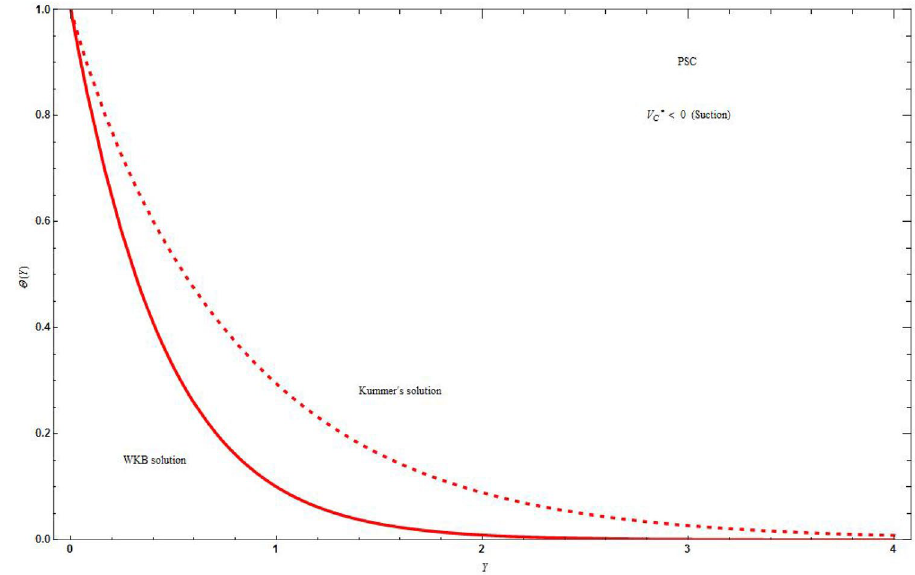
Figure 7. The concentration distribution plot shows the difference between curves of Kummer’s 1 V solution and WKB solution in PSC case and suction boundary keeping the parameters as ∗ C = − 1, ϑ 3, � 0.1 . Blue solid lines are for the base fluid and red dotted lines M C Sc K r � ∗ = = = = = = = = − (cid:31) (cid:30) Al 2 O 3 / water denotes the hybrid nanofluid Cu −